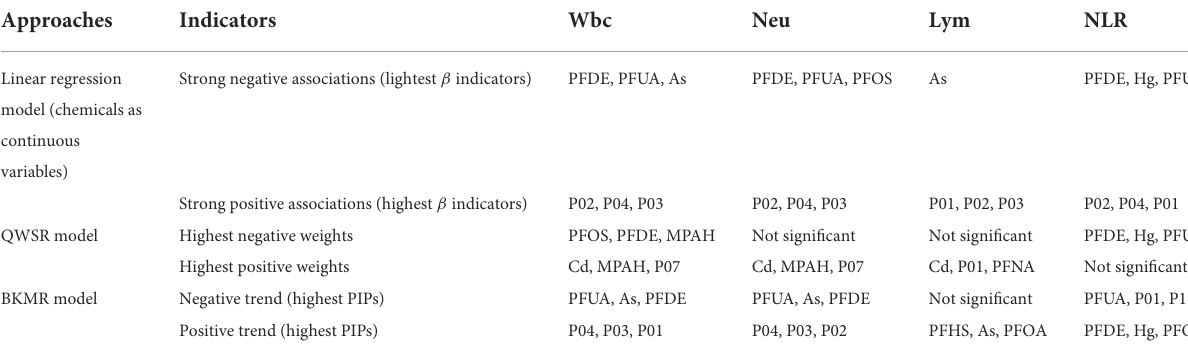
TABLE 2 A summary of results using the three approaches to evaluate the link between 21 chemicals and immunoinflammatory biomarkers ( n = 1,723).